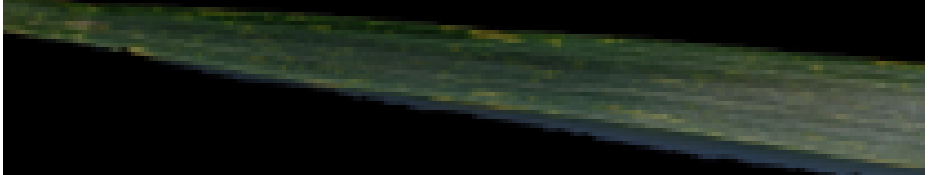
Figure 4. Leaf cropping in the images.